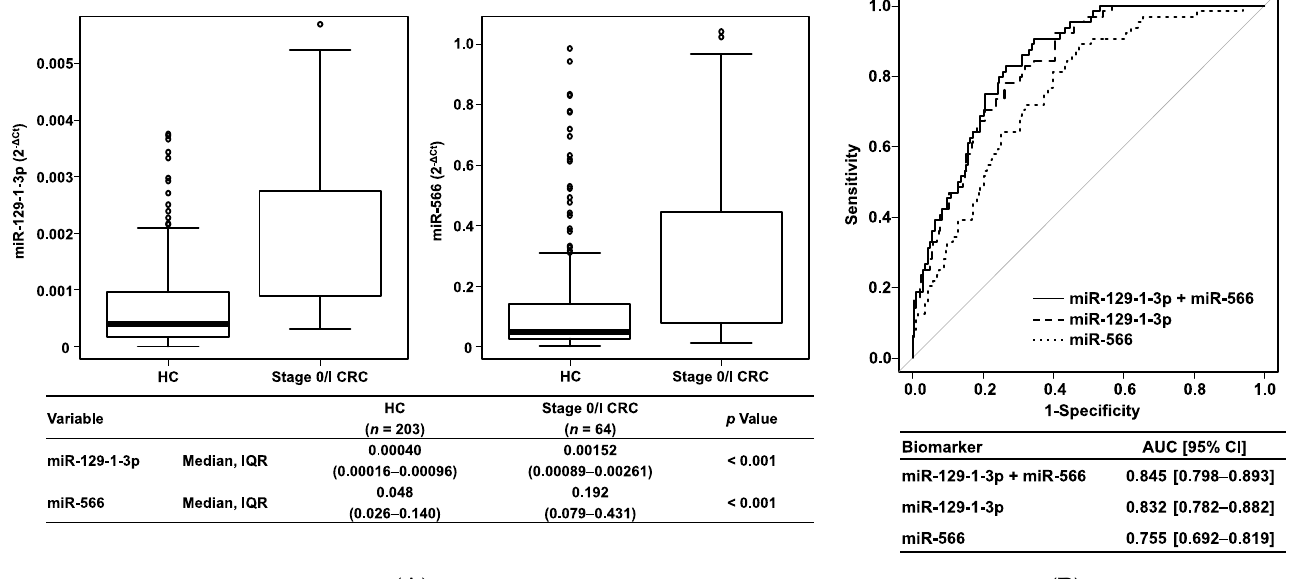
Figure 3. Urinary miRNA biomarker in stage 0/I CRC. ( A ) Boxplots. ( B ) Receiver operating charac- teristics curves. HC, healthy control; CRC, colorectal cancer; IQR, interquartile range; AUC, area under the curve; 95% CI, 95% confidence interval.